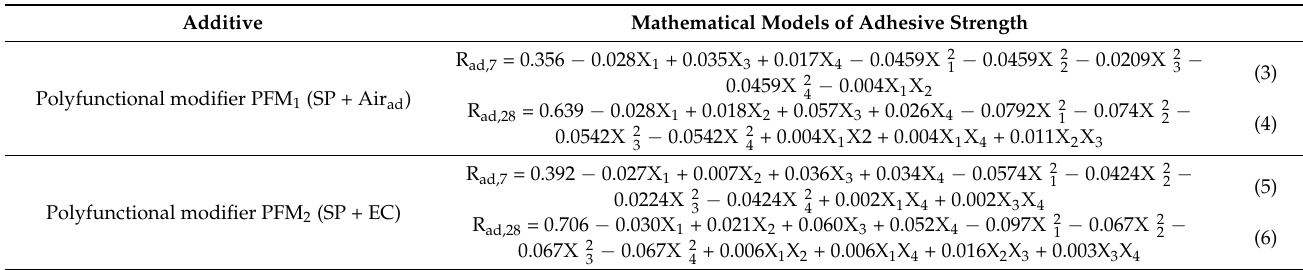
Table 6. Mathematical models of the adhesive strength of cement–ash mortars. Mathematical Models of Adhesive